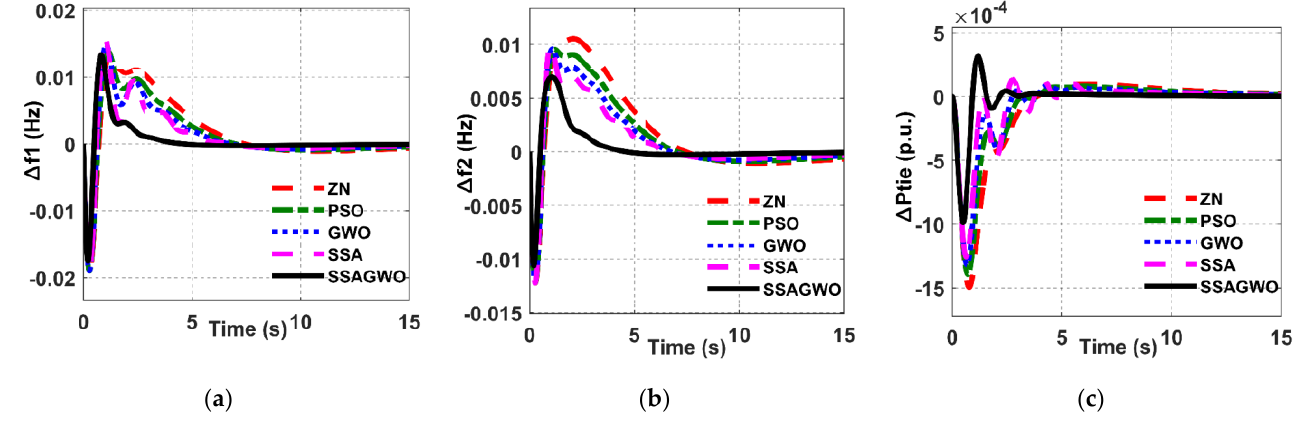
Figure 10. The frequency deviation responses of the optimization techniques and conventional Ziegler – Nichols method for tuning PID controller parameters for case III: ( a ) The frequency deviation of area 1; ( b ) The frequency deviation of area 2; ( c ) The power deviation of the tie line. Table 8. Frequency and power deviation in the tie-line power of case III.